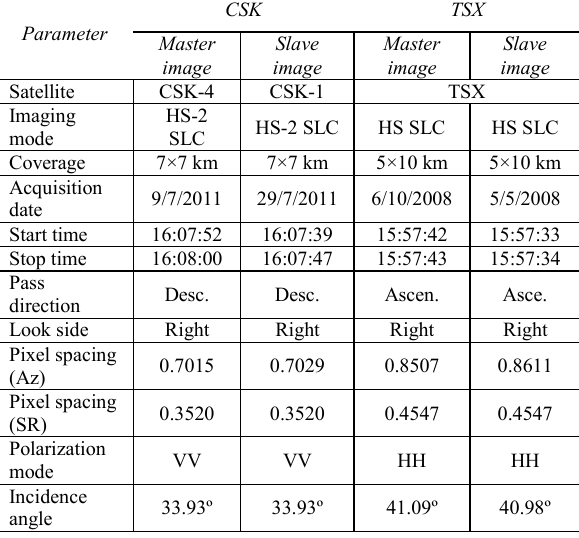
Table1. Characteristics of CSK and TSX InSAR-pairs